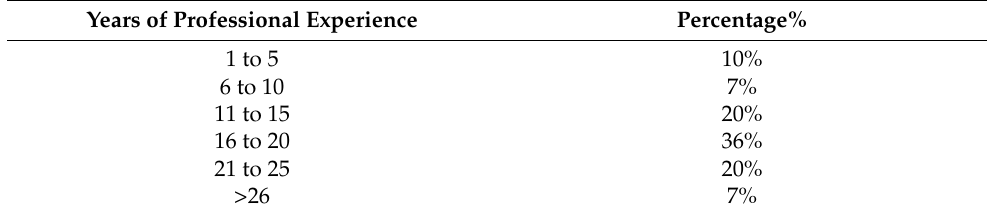
Table 6. Years of professional